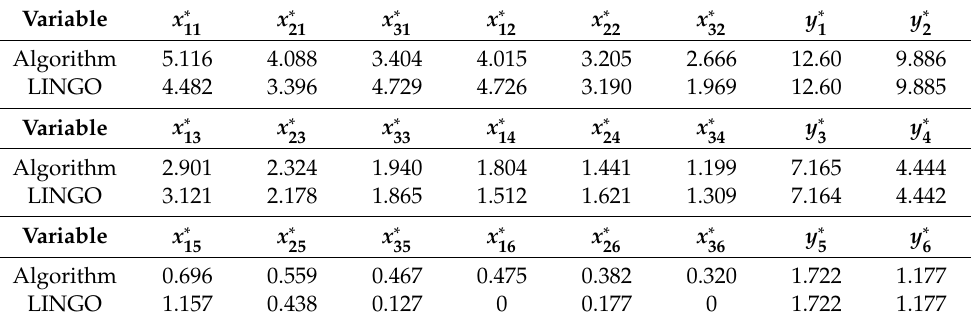
Table 2. The optimal bandwidth allocation for customer s